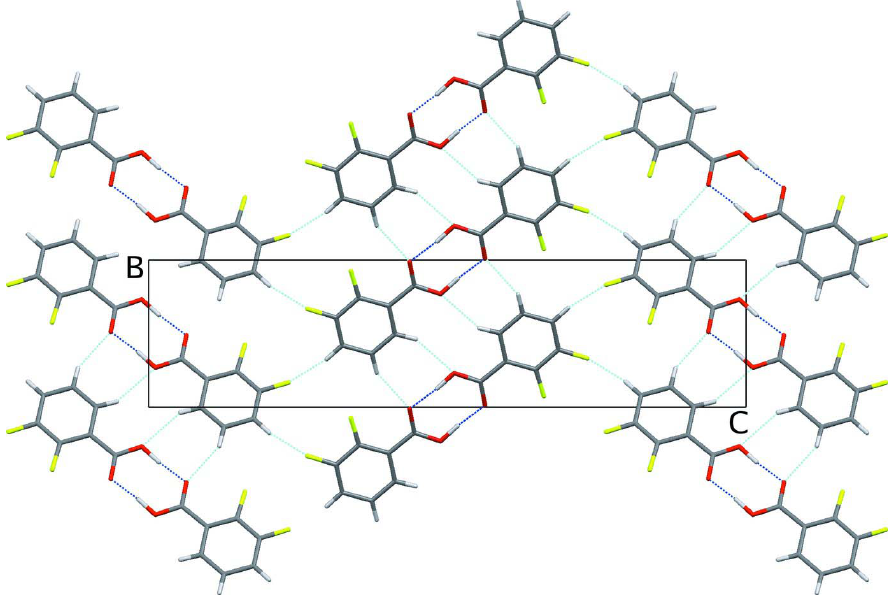
Figure 2 The packing of 2,3-difluorobenzoic acid shown along [010]. Hydrogen bonds are marked with blue, dashed lines. Weak C —H···F and C—H···O interactions are shown as light-blue, dashed